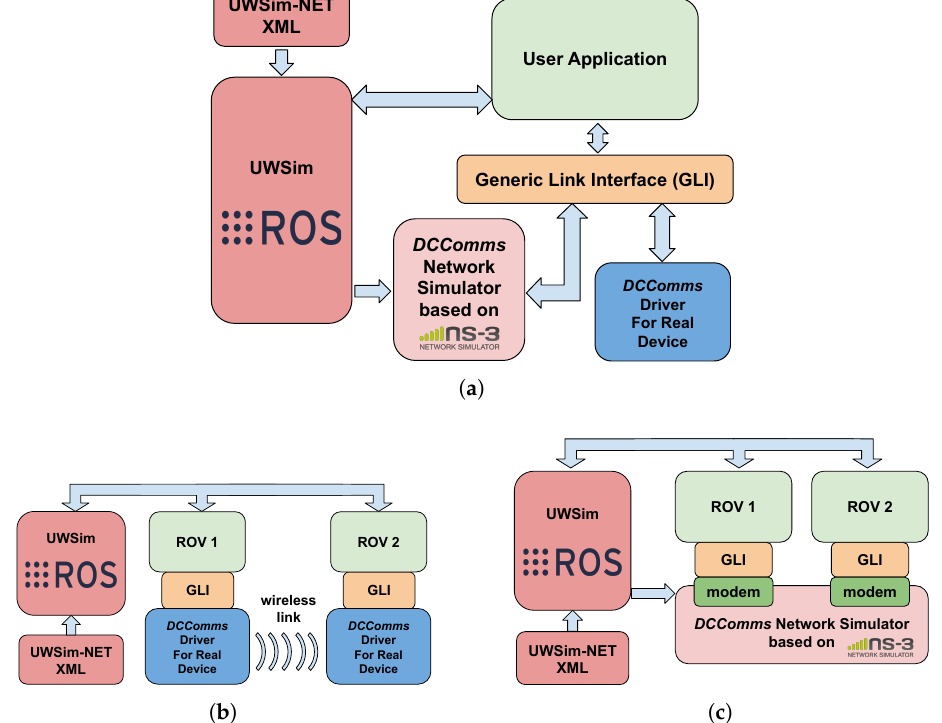
Figure 2. UWSim-NET Architecture: ( a ) block diagram of the UWSim-NET elements; ( b ) block diagram of an experiment with two ROVs using real modems; and ( c ) block diagram of an experiment with two ROVs modeling the